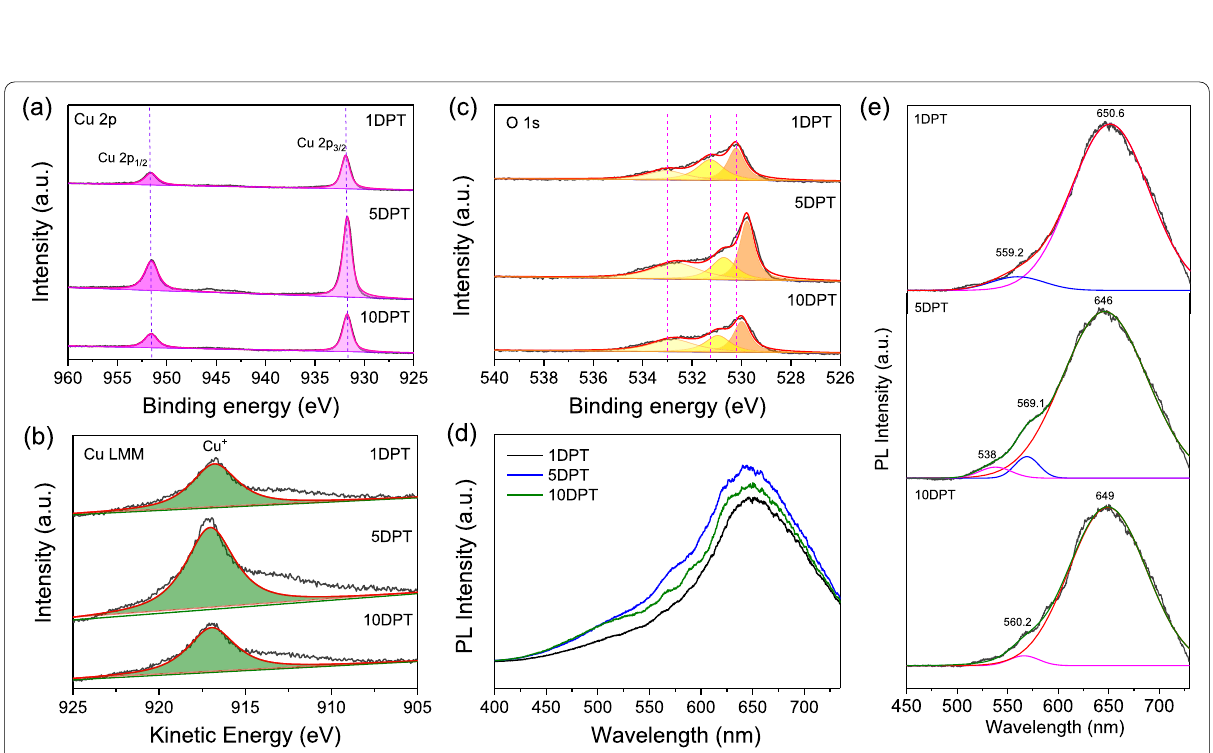
Fig. 4 XPS spectra of ( a ) Cu 2p; ( b ) Cu LMM; and ( c ) O 1s. d PL spectra of 1DPT, 5DPT and 10DPT, with Lorentzian peaks divided in ( e